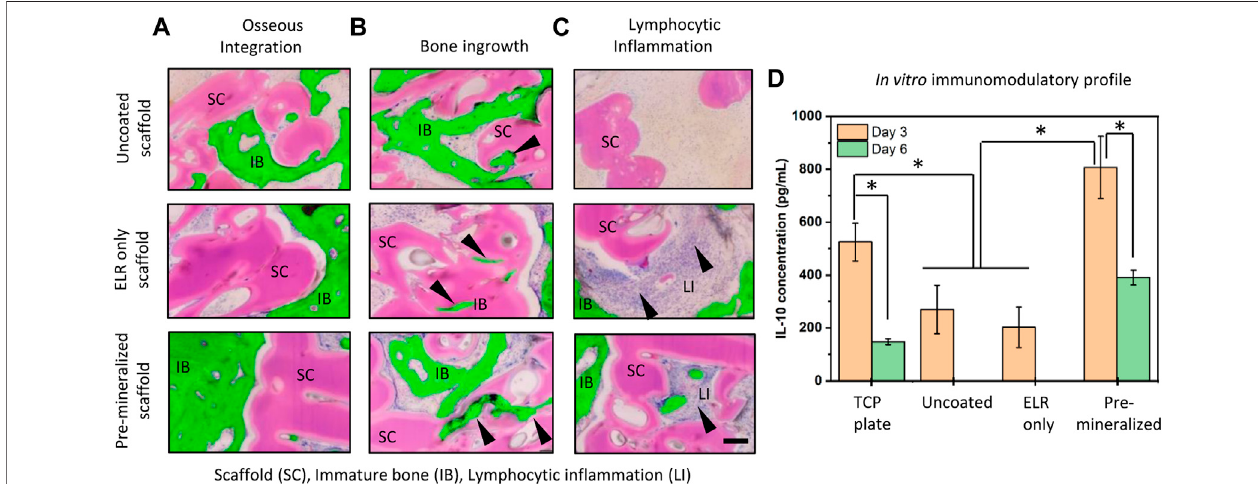
FIGURE4| HistologicalsectionsstainedwithGiemsa-Eosindepicting (A) osseousinteractionwiththeimplantatthebone-implantinterface, (B) boneingrowthinto small pores and cavities of the scaffolds, and (C) lymphocytic in fl ammation with in fi ltrating cells (arrow heads) primarily around “ ELR only ” coating and “ Pre-mineralized ” scaffolds.Newlyformedboneinthehistologyimageshavebeenpseudocoloredandrepresentedwithgreentoshowcleardifferencebetweenimmature(new)boneand scaffold.Scalebar=200 µm.Scaffold(SC),Immaturebone(IB),Lymphocyticin fl ammation(LI). (D) EstimationofIL-10concentrationssecretedfrommacrophages after3and6 daysofcultureondifferenttestsamples.*representssigni fi cantdifference p < 0.005,estimated usingtwo-wayANOVAinGraphPadPrismver.6software.